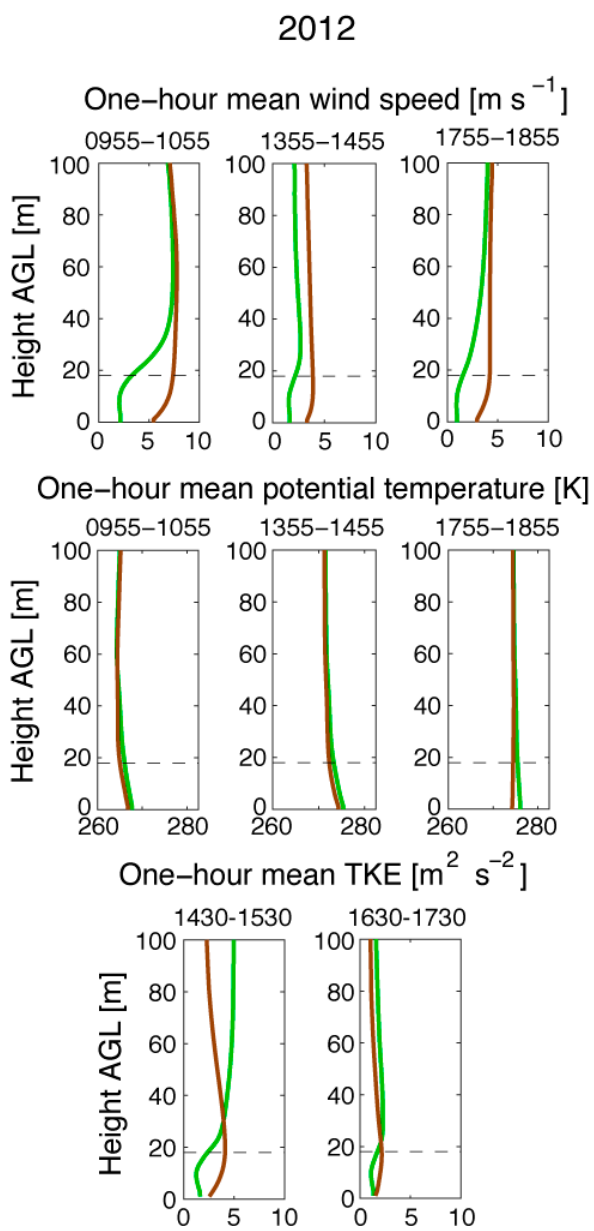
Figure 12. As in Figure 8, but for the 2012 case.